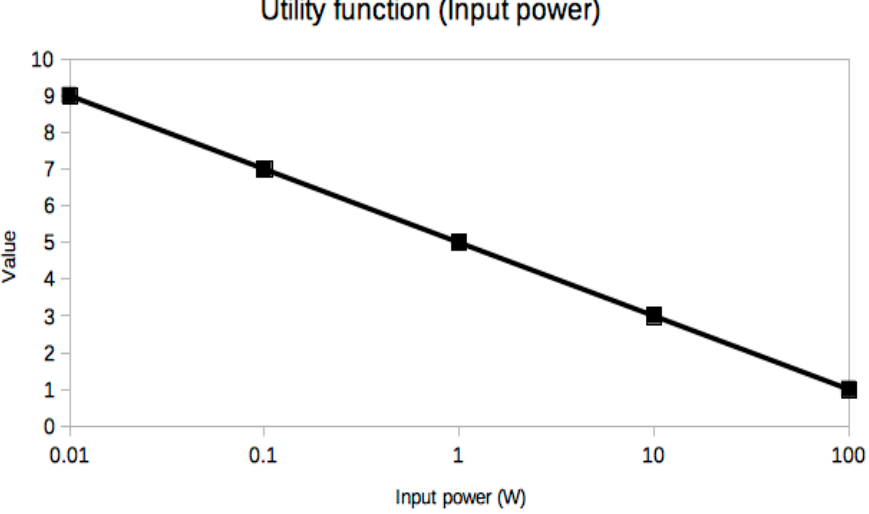
Figure 4. Utility function for Input Power.